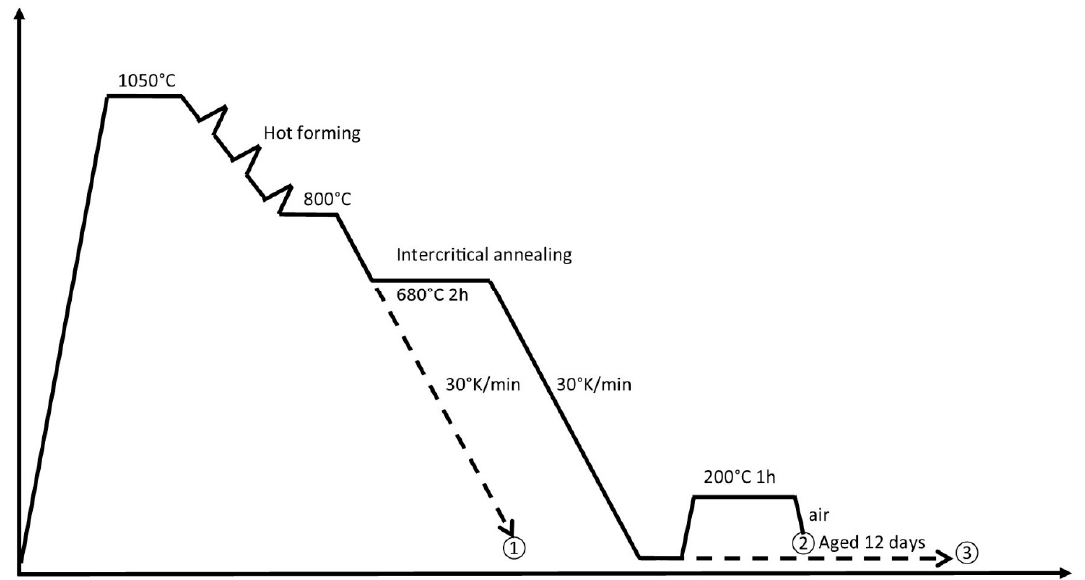
Figure 1. Di ff erent heat treatments and obtainable hardness levels of steel A0. Figure 1. Different heat treatments and obtainable hardness levels of steel A0.